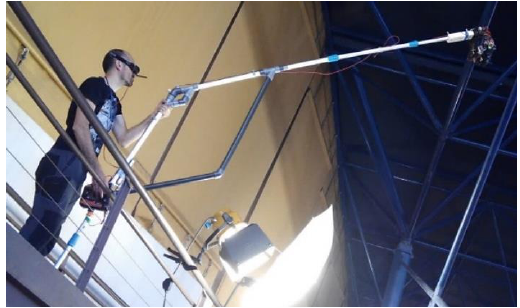
Figure 2. Pole platform employed for the photogrammetric data acquisition in Cueva Pintada.